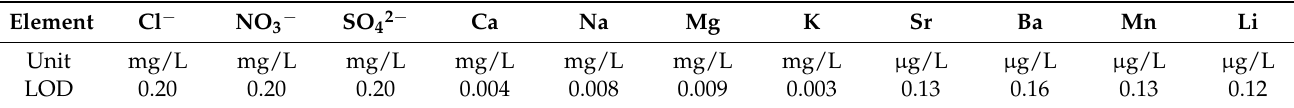
Table 2. Limit of detection (LOD) of elements in